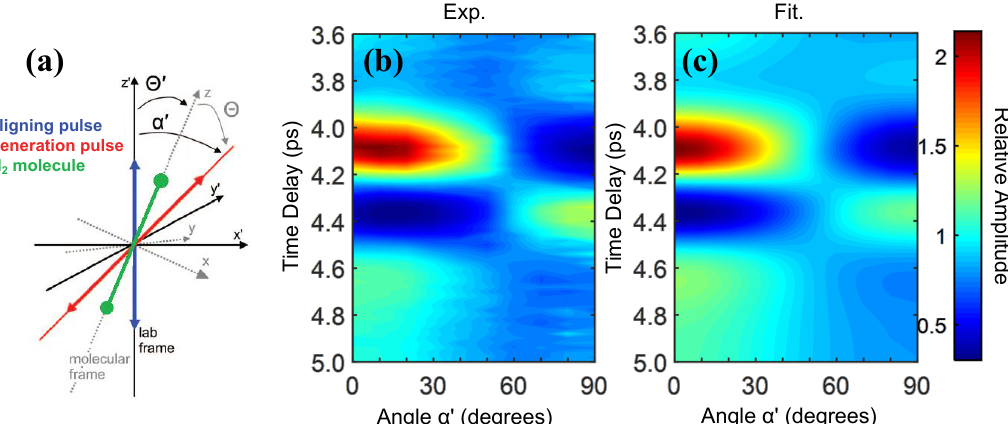
Figure 7. The reconstruction of the single molecular response: ( a ) the polar and azimuthal angles about the polarization axis of the aligning and the generation pulses, as well as the corresponding coordinate transformation; and ( b , c ) the experimental results and fittings of the relative amplitudes of the 21st harmonic (the aligned yields divided by the random pointing yields), which are functions of the aligned angles ( α (cid:48) ) and the time delay between the aligning and the generation